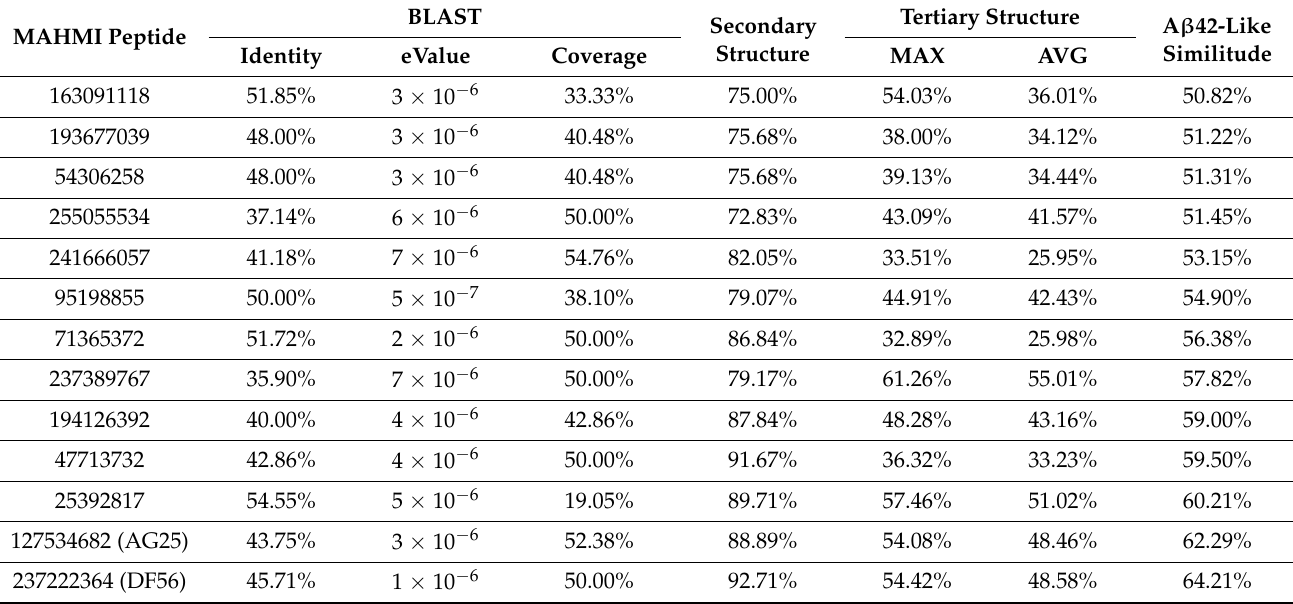
Table 1. Bacterial peptides contained in the MAHMI database that obtained the best score against the A β 42 peptide. A β 42-like similitude score considers sequence, secondary figure and tertiary alignment scores. BLAST = Basic Local Alignment Search Tool, eValue = expected value, MAX = maximum identity, AVG = average identity. MAHMI